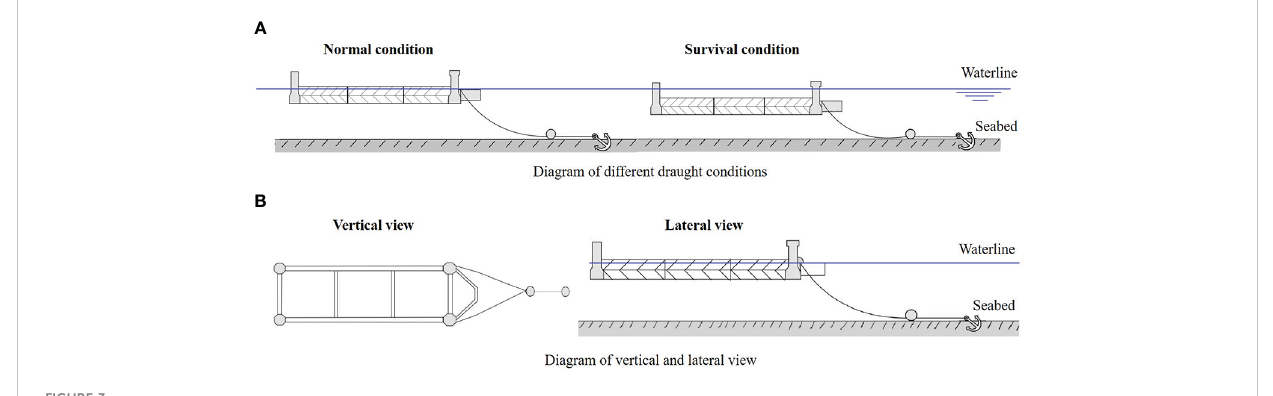
FIGURE 3 Diagram of fi sh farm platform under different draughts and different